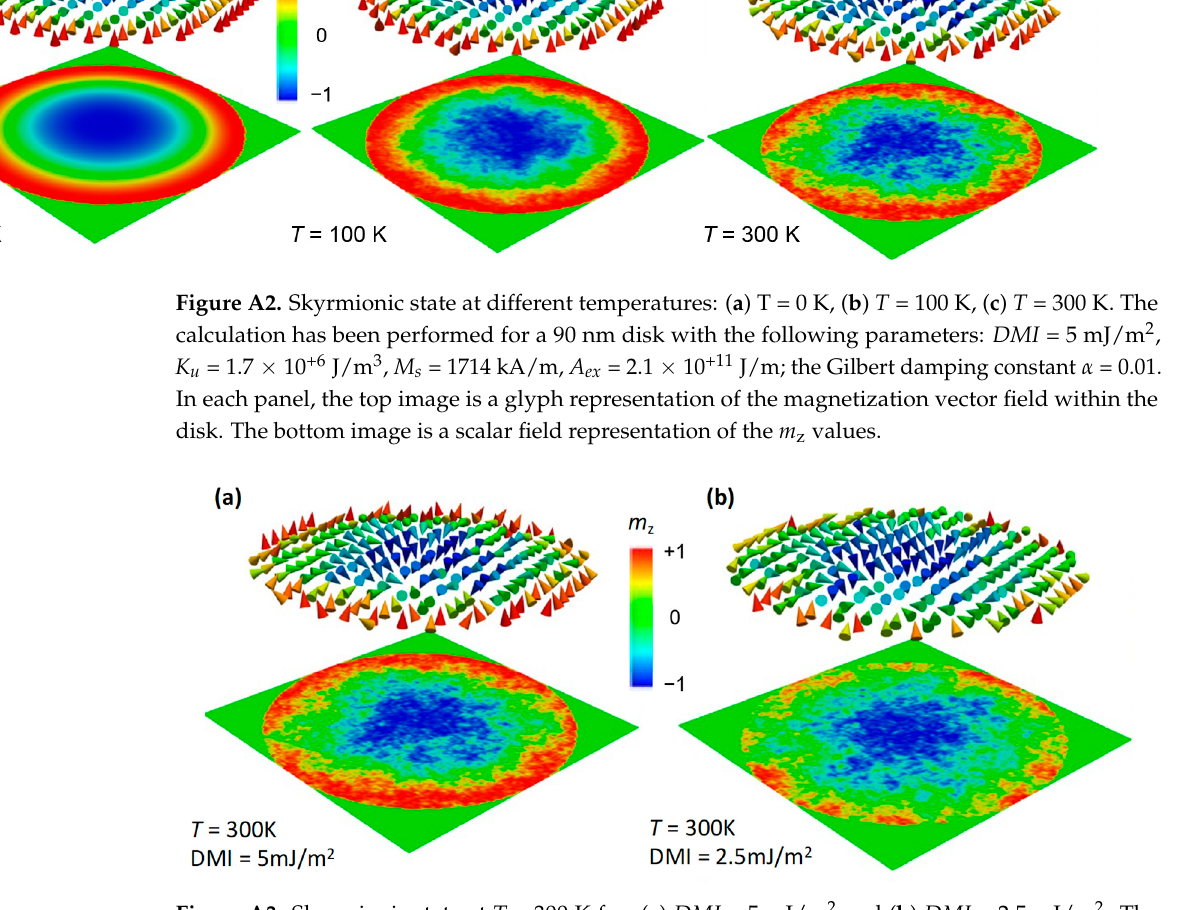
panel, the top image is a glyph representation of the magnetization vector field within the disk. The bottom image is a scalar field representation of the m z values.